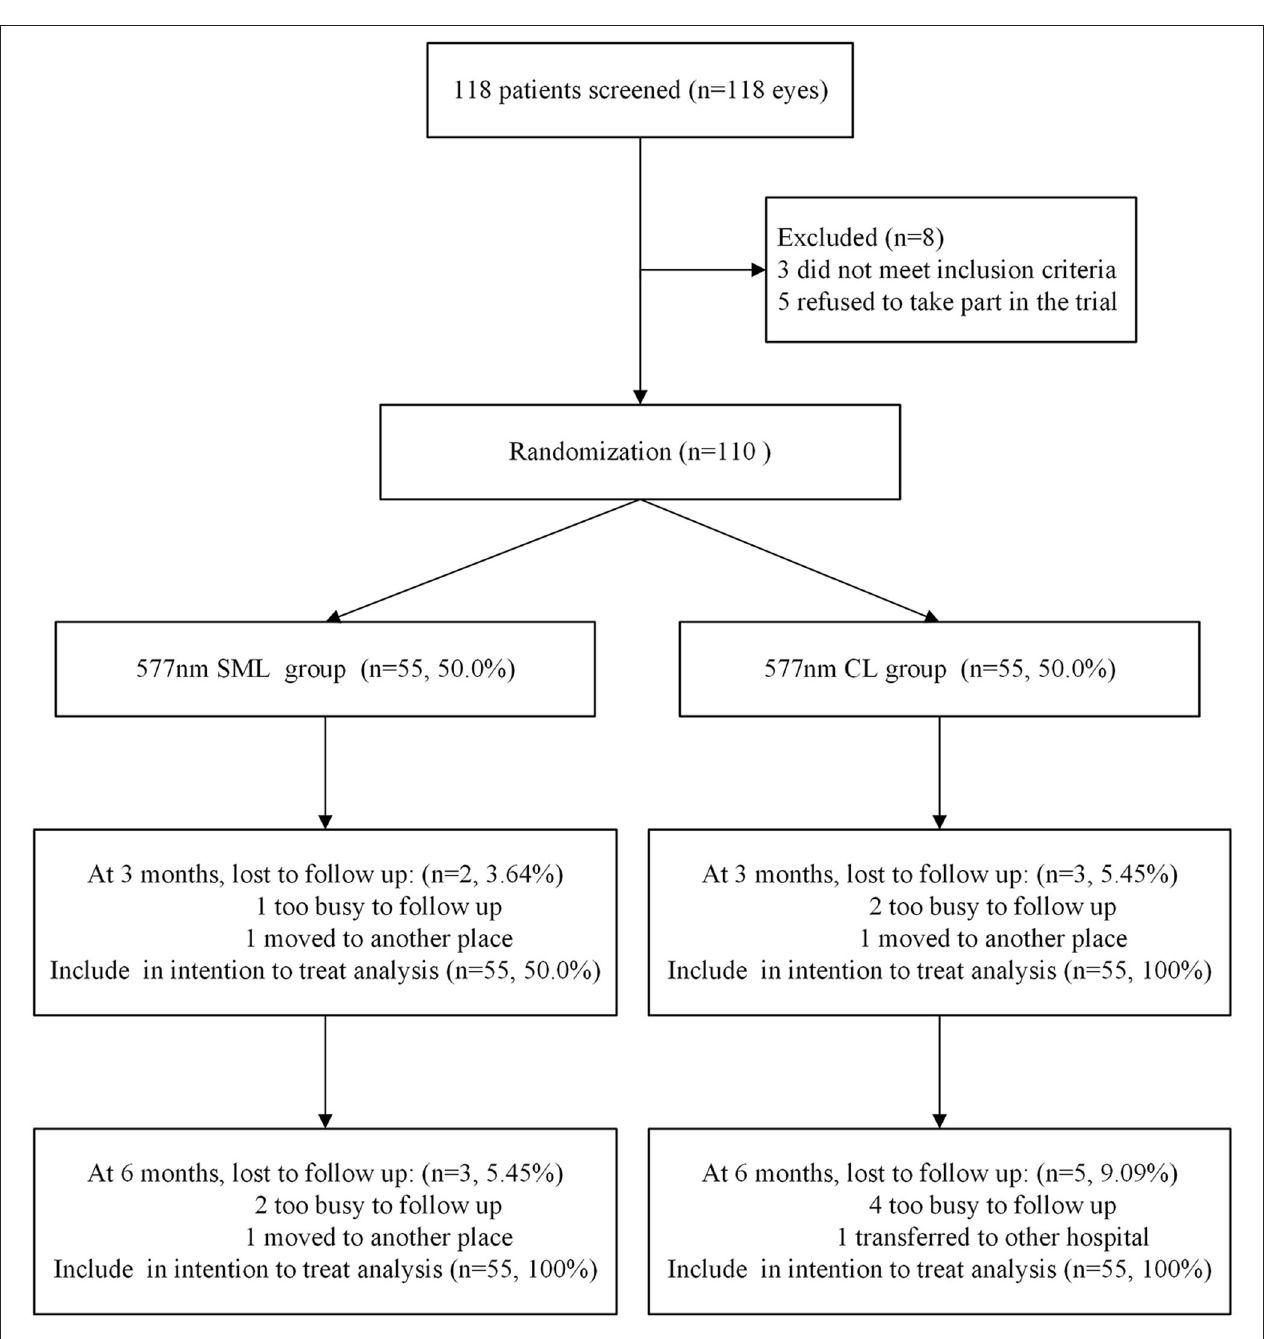
FIGURE 1 | Study design flow